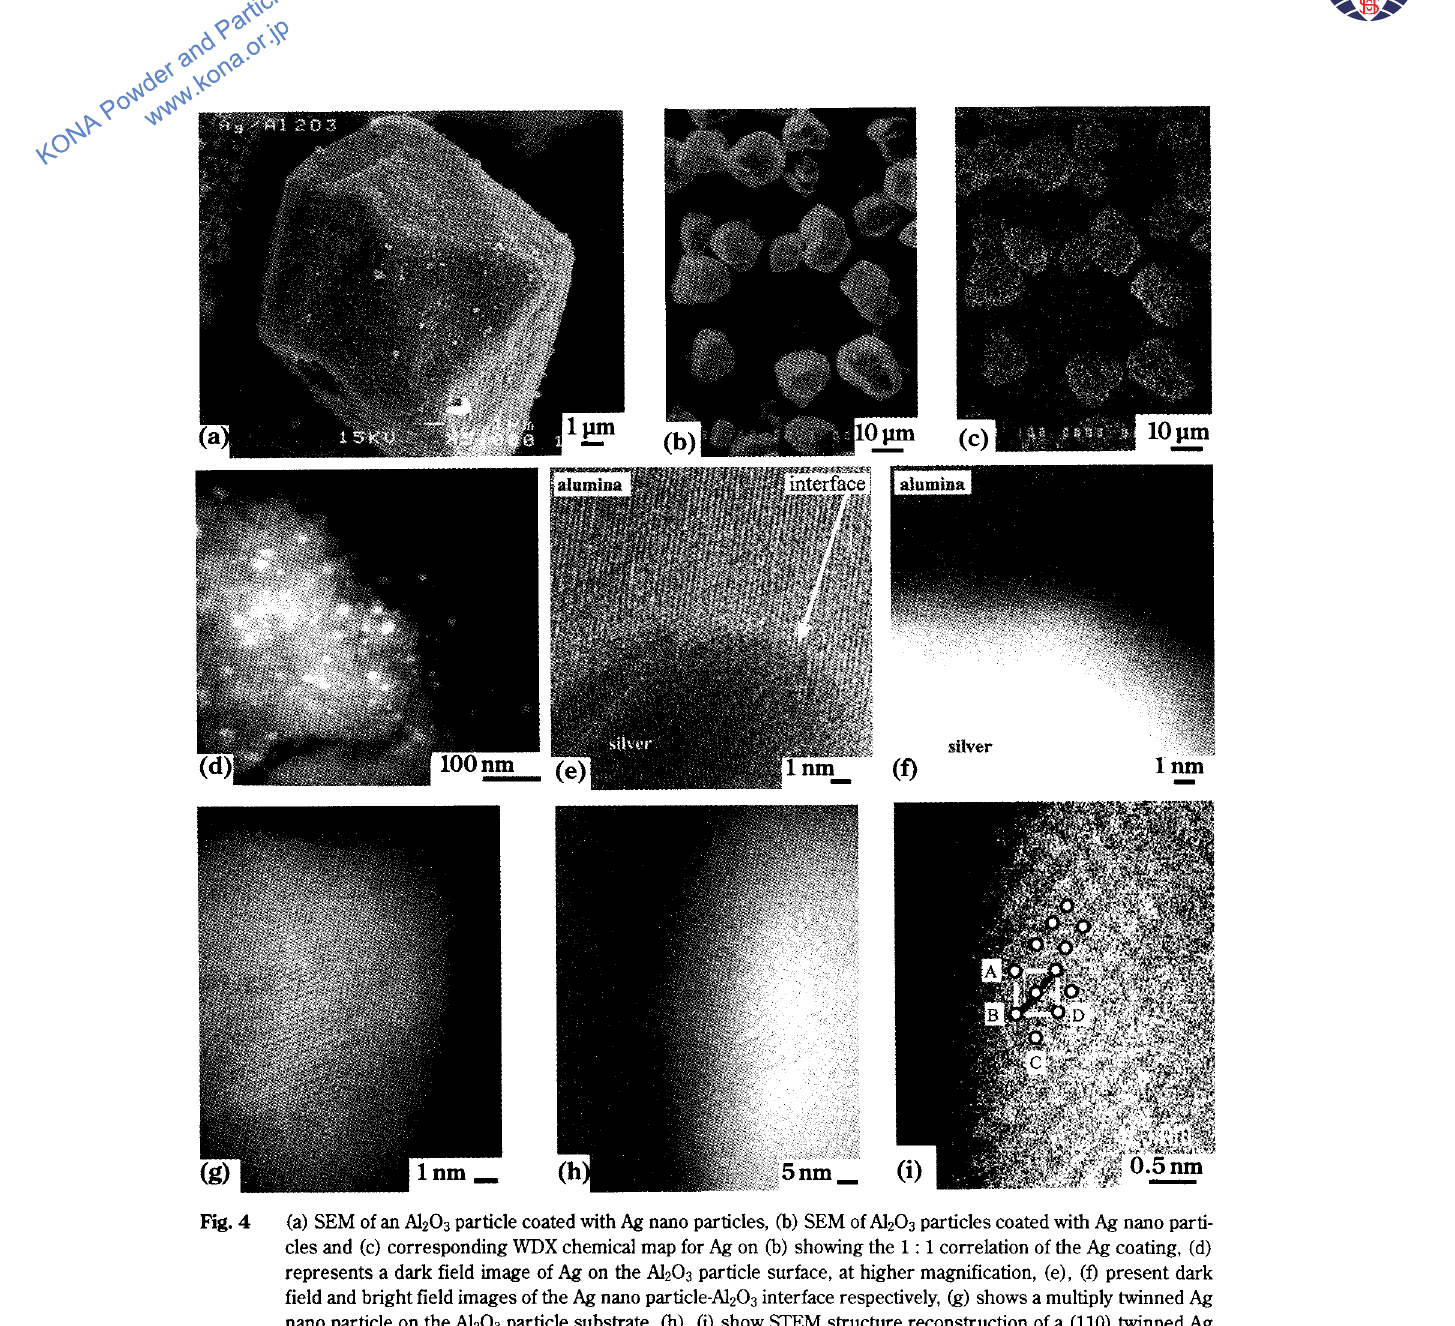
Fig. 4 (a) SEM of an Ah03 particle coated with Ag nano particles, (b) SEM of Ah03 particles coated with Ag nano parti cles and (c) corresponding WDX chemical map for Ag on (b) showing the 1 : 1 correlation of the Ag coating, (d) represents a dark field image of Ag on the Ab03 particle surface, at higher magnification, (e), (f) present dark field and bright field images of the Ag nano particle-Ah03 interface respectively, (g) shows a multiply twinned Ag nano particle on the Al203 particle substrate, (h), (i) show STEM structure reconstruction of a (110) twinned Ag nano particle on AbOJ.